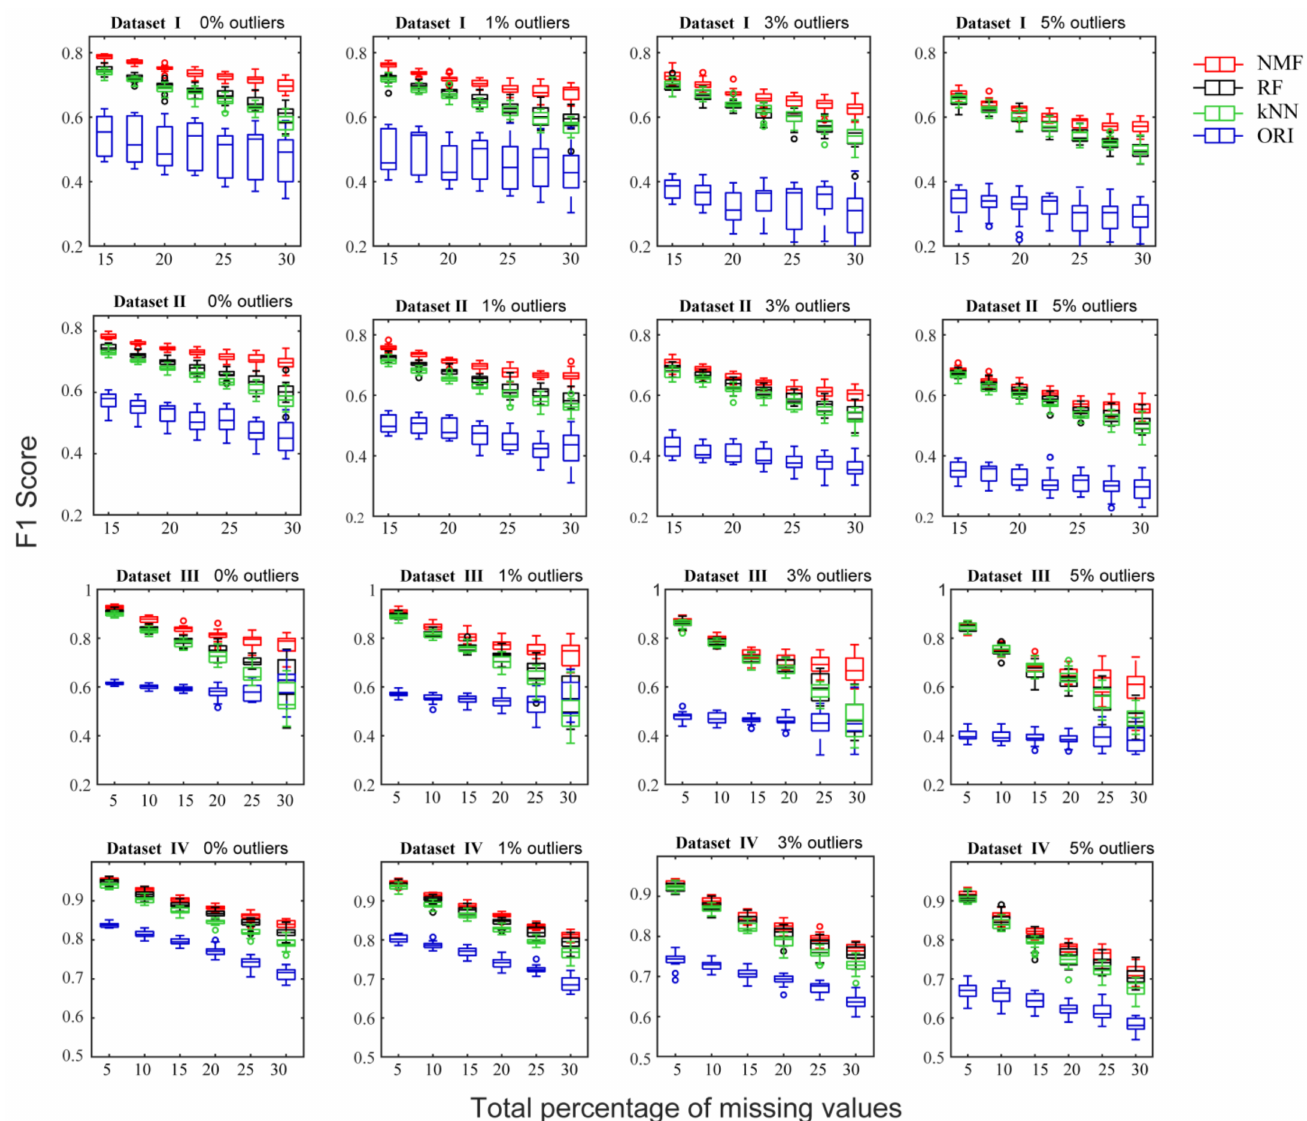
Figure 4. The F1 scores of predicted CCN given different rates of missing values (horizontal axis) for the NMF, RF, kNN, and ORI methods, using four metabolomics